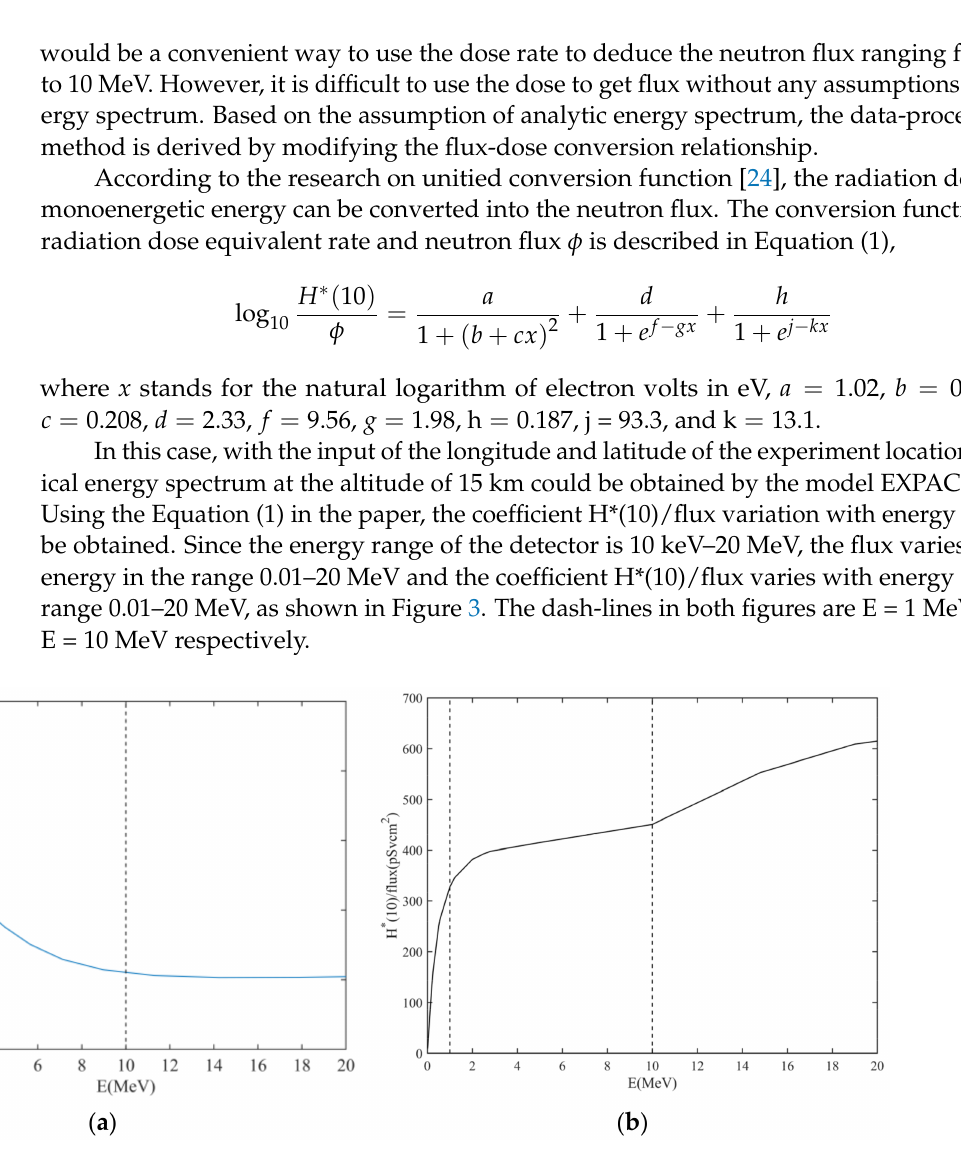
Figure 3. ( a ) The flux varies with energy at the altitude of 15 km above the experimental loca- tion, ( b ) the coefficient H*(10)/flux varies with energy. The dash-lines in ( a , b ) are E = 1 MeV and E = 10 MeV,